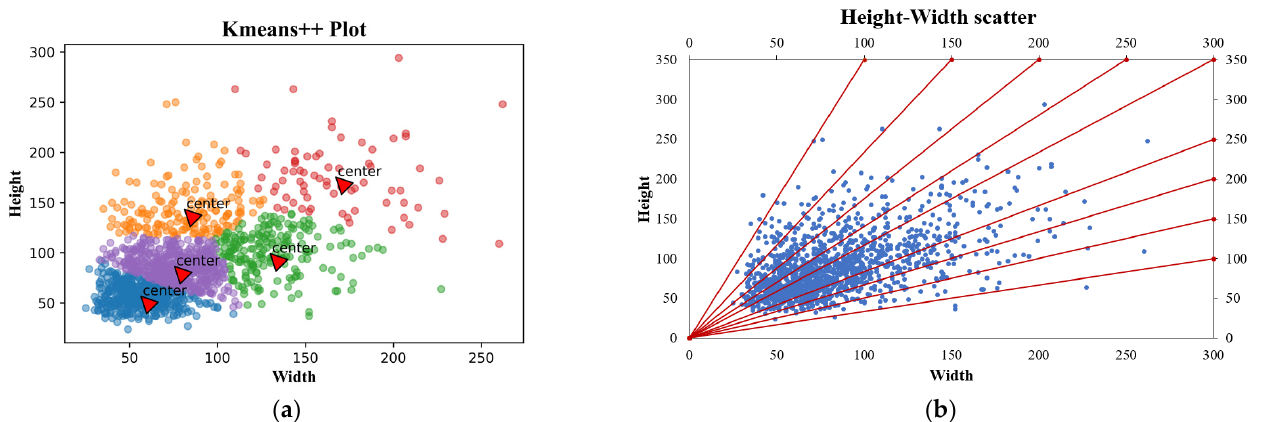
Figure 8. Bounding box analysis of the training samples: ( a ) the results of K-Means ++; ( b ) the distribution of the boxes’ ratios.